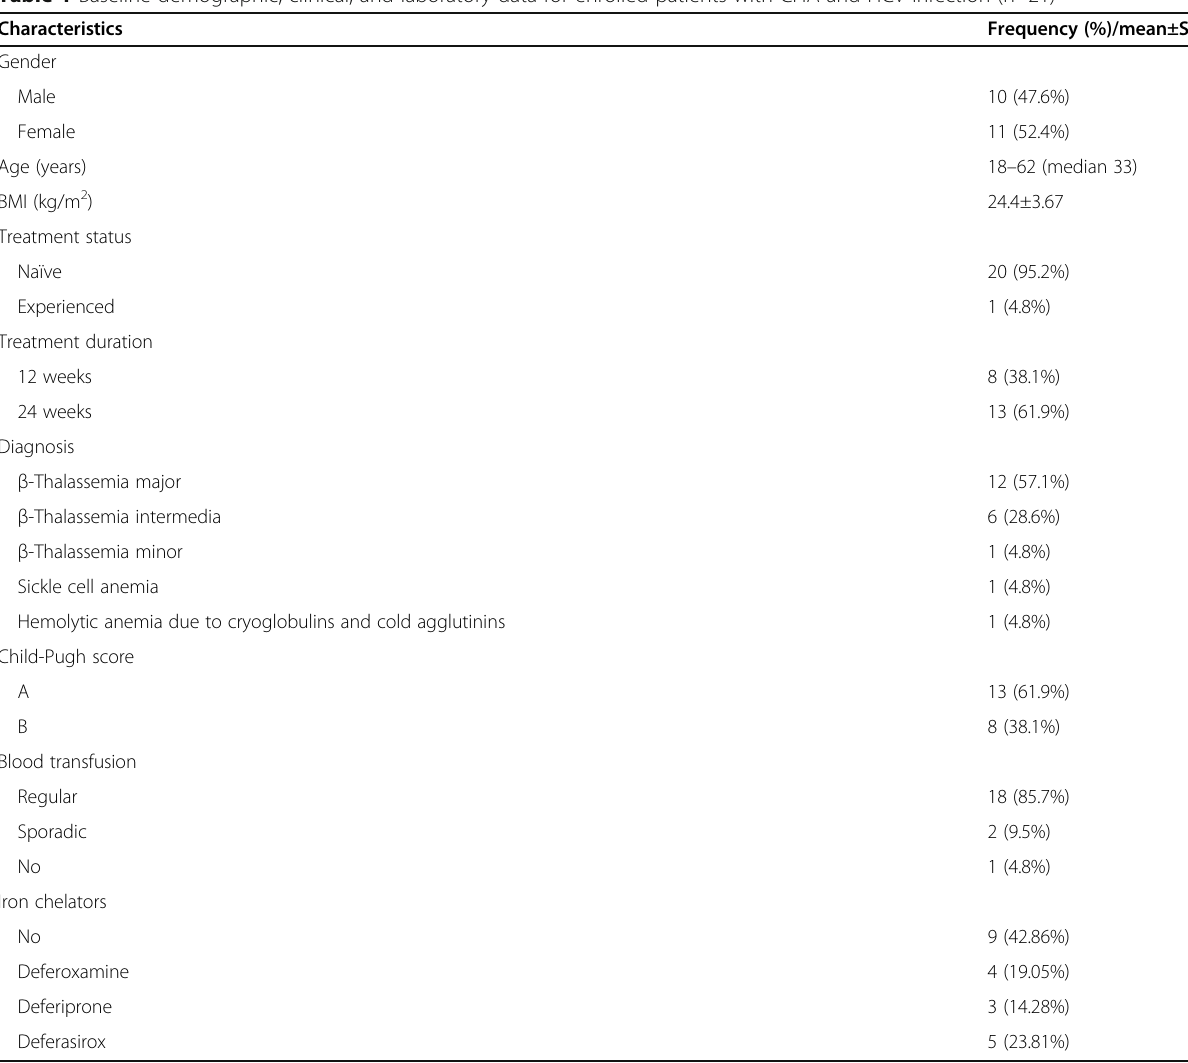
Table 1 Baseline demographic, clinical, and laboratory data for enrolled patients with CHA and HCV infection (n=21) Characteristics